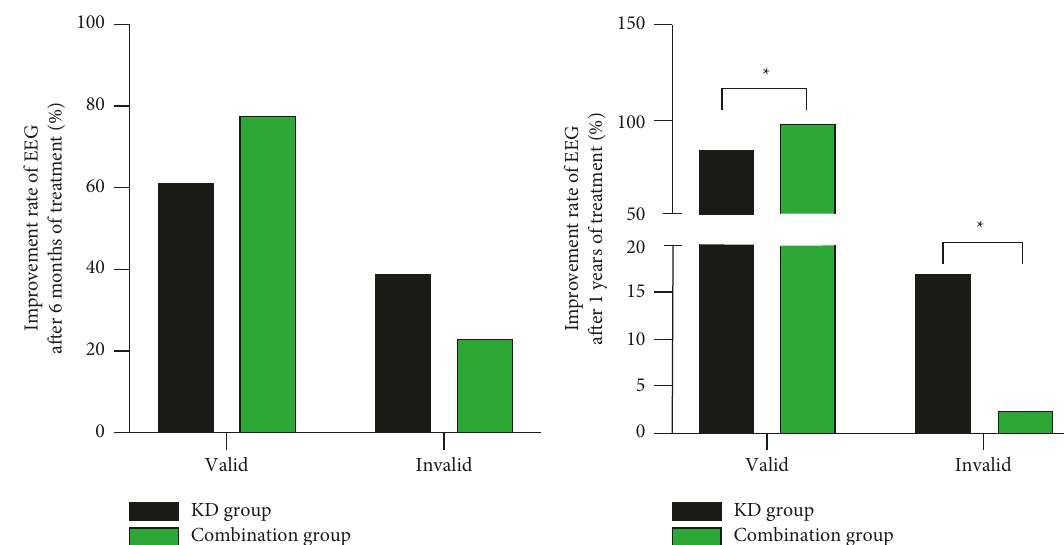
Figure 2: EEG improvement between the two groups of children. ∗ Difference between group comparisons, P < 0 .